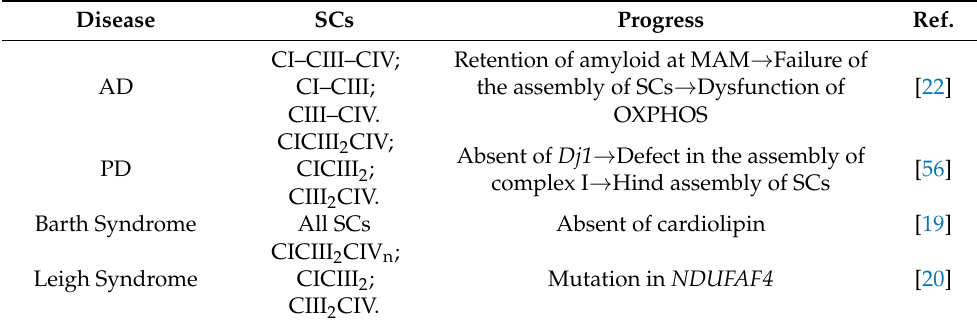
Table 4. The role of SCs in the progression of diseases. Disease SCs Progress Ref. Retention of amyloid at MAM → Failure of AD the assembly of SCs → Dysfunction of OXPHOS CICIII 2 CIV; Absent of Dj1 → Defect in the assembly of PD complex I → Hind assembly of